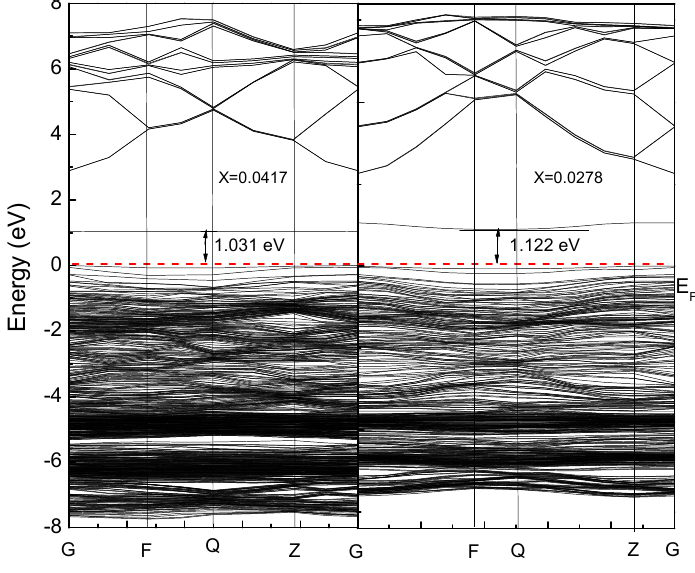
Figure 5. Band structure of Cu x Zn 1-x O (x = 0.0417, 0.0278).